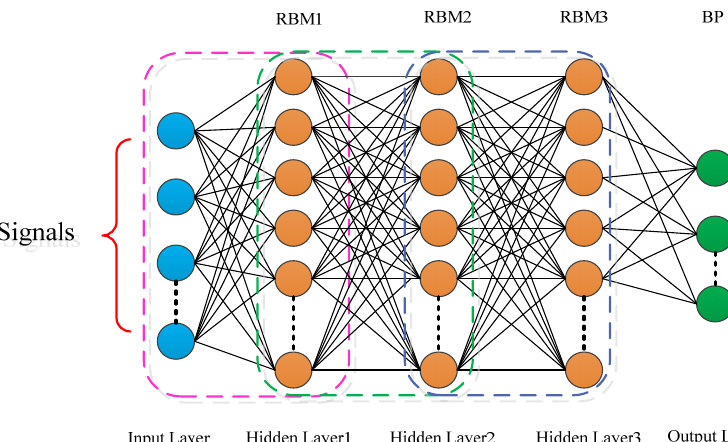
Figure 4. Typical structure of the employed DBN.